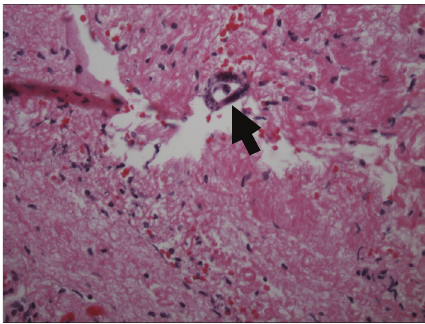
Figure 7: Section of the liver from KMS417. Trematode ova are present within the portal tract surrounded by mixed inflammatory